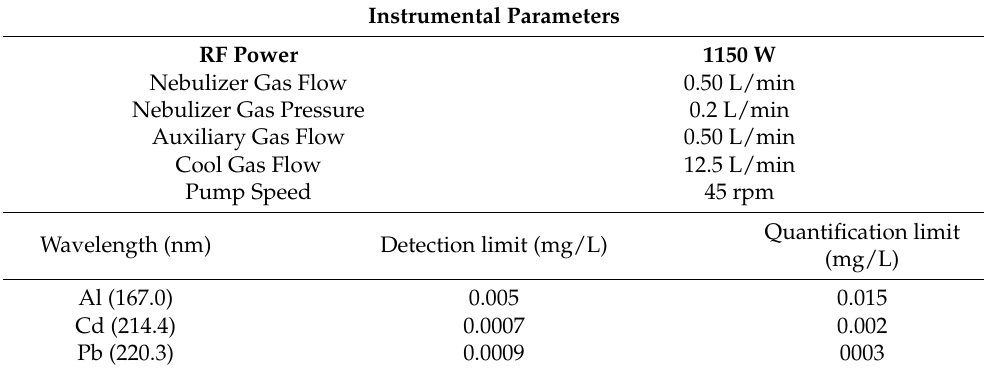
Table 2. Instrumental parameters of the